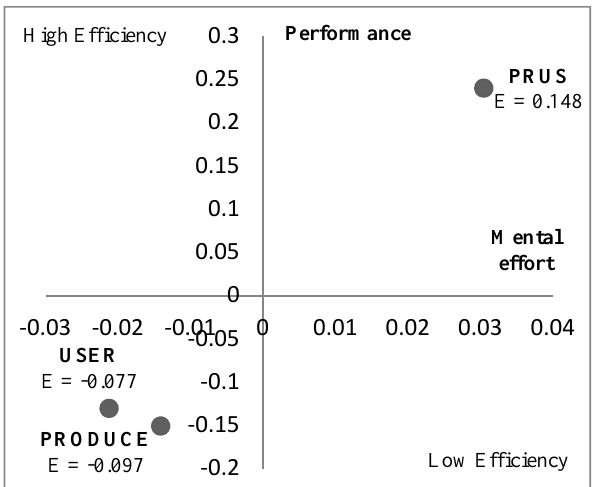
Figure 6. Representation of relative condition efficiency (E) for producing screencast (PRODUCE), produce and user of screencast (PRUS) and user of screencast (USER) for moderate question.